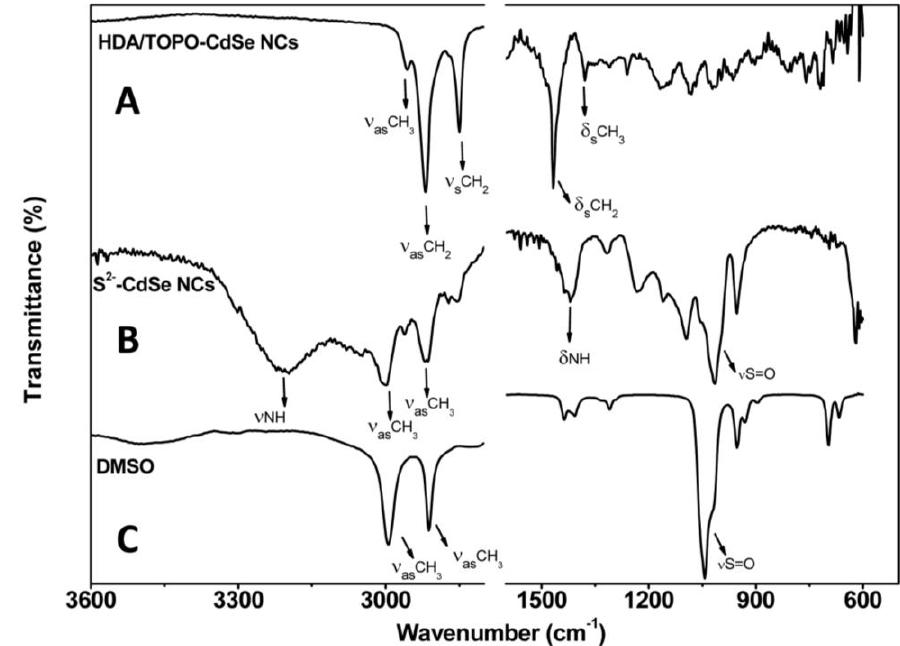
Figure 1. Attenuated total reflection Fourier transform infrared (ATR-FTIR )absorption spectra of ( A ) CdSe NCs coated by trioctylphosphine oxide (TOPO) and hexadecylamine (HDA) in chloroform; ( B ) S 2− stabilized CdSe nanocrystals (NCs) in dimethyl sulfoxide (DMSO) and ( C ) pure